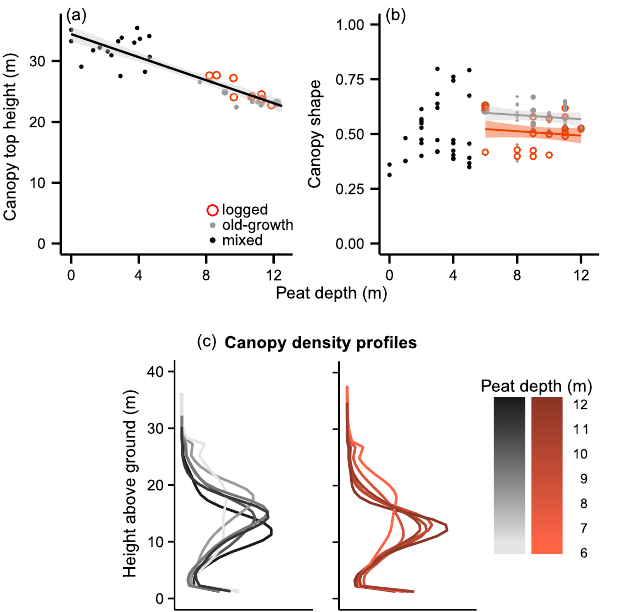
Figure 4. Changes in (a) mean gap area, (b) gap fraction, (c) scal- ing exponent α of the GSFD and (d) transition parameter θ of the GSFD with peat depth in old-growth, logged and mixed peat swamp forest plots. Data are shown for the 8m cross-section of the CHM. Logged forest dominated the first half of the peat depth gradient (0–5m peat depth) preventing any comparison between old-growth and logged plots. Fitted regression lines are plotted with 95% con- fidence